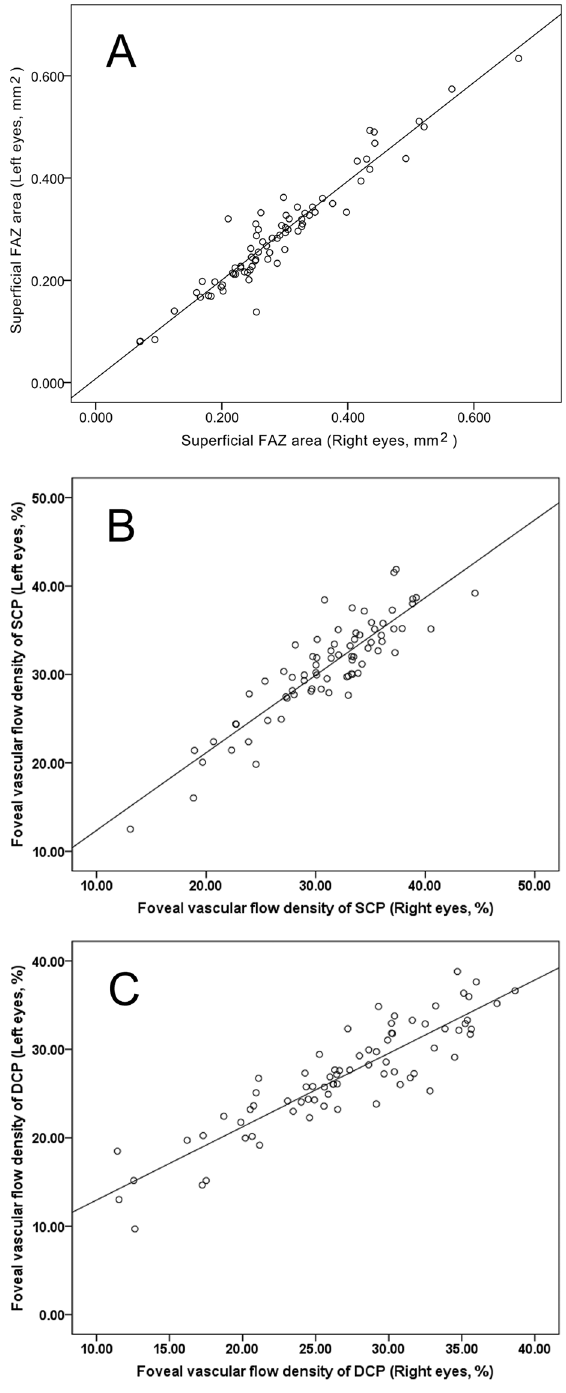
Figure 2. Scatterplots for FAZ ( A ), foveal vascular flow density of SCP ( B ) and DCP ( C ), showing the correlation between right and left eyes. The plots clearly show that right and left eyes are highly correlated for FAZ ( r = 0.958, P < 0.001), foveal vascular flow density of SCP ( r = 0.888, P < 0.001) and DCP ( r = 0.895, P <